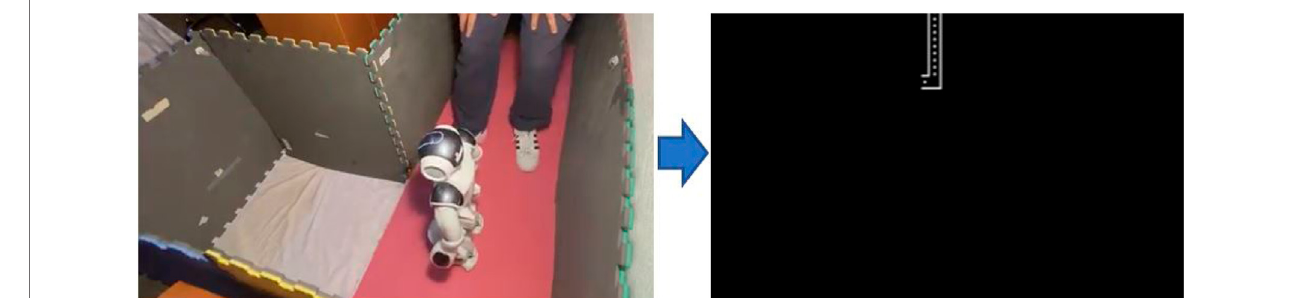
FIGURE 10 | Test: left turn.